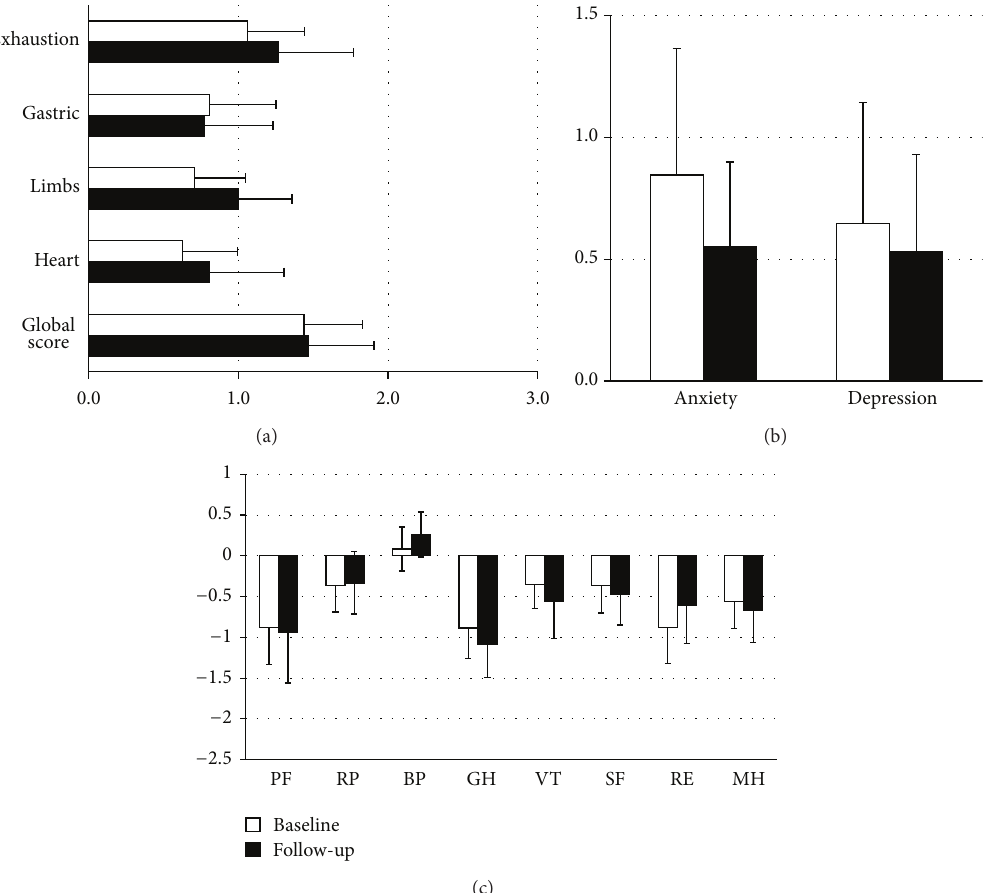
Figure 1: 𝑧 -scores (mean ± SEM scores) for (a) GBB-24, (b) HADS, and (c) SF-36 in male patients with congenital adrenal hyperplasia at baseline and after 2-year follow-up. Decade- and sex-adjusted 𝑧 -scores were calculated for subgroup analysis. Higher scores indicate greater impairment of well-being, anxiety, or depression in GBB-24 and HADS. Higher scores in SF-36 indicate less pain or less impaired functioning. Therespectivecontrolgrouphasthe 𝑧 -scorevalue0.Physicalfunctioning(PF);rolefunctioningphysical(RP);bodilypain(BP);generalhealth perception (GH); vitality (VT); social functioning (SF); role functioning emotional (RE); mental health (MH).